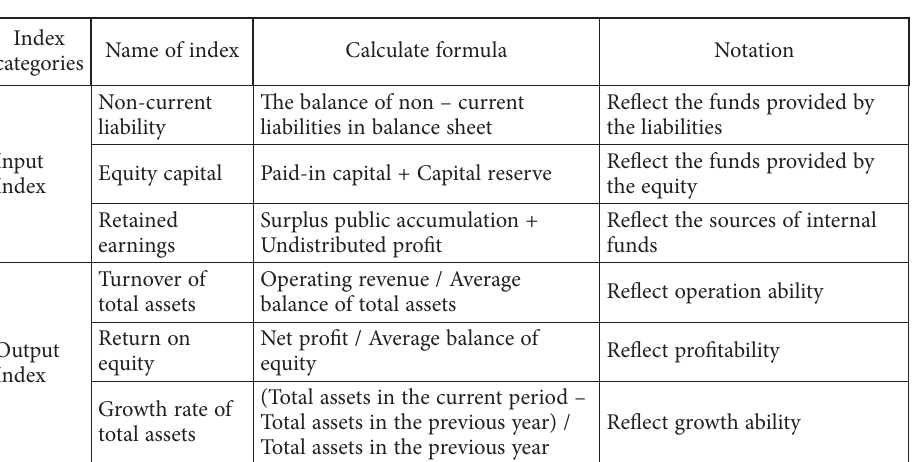
Table 4. Input and output index